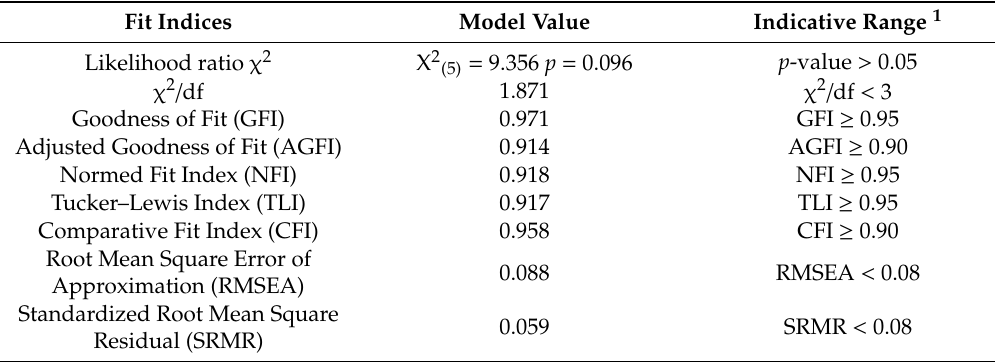
Table 5. Fit indices of the model, with indicative range for